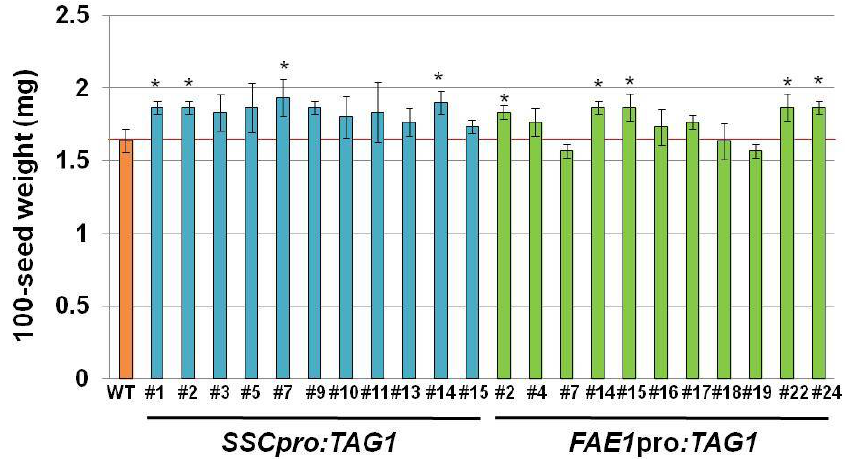
Figure 4. Seed weight of independent transgenic lines. Seed weight of independent transgenic lines expressing TAG1 under control of the SSC promoter or FAE1 promoter. Values are means ± standard deviation of three independent measurements of the weight of 100 seeds. Statistical analysis carried out by Student’s t -test. Asterisks indicate a significant difference between the WT and transgenic lines at p < 0.05 (*).